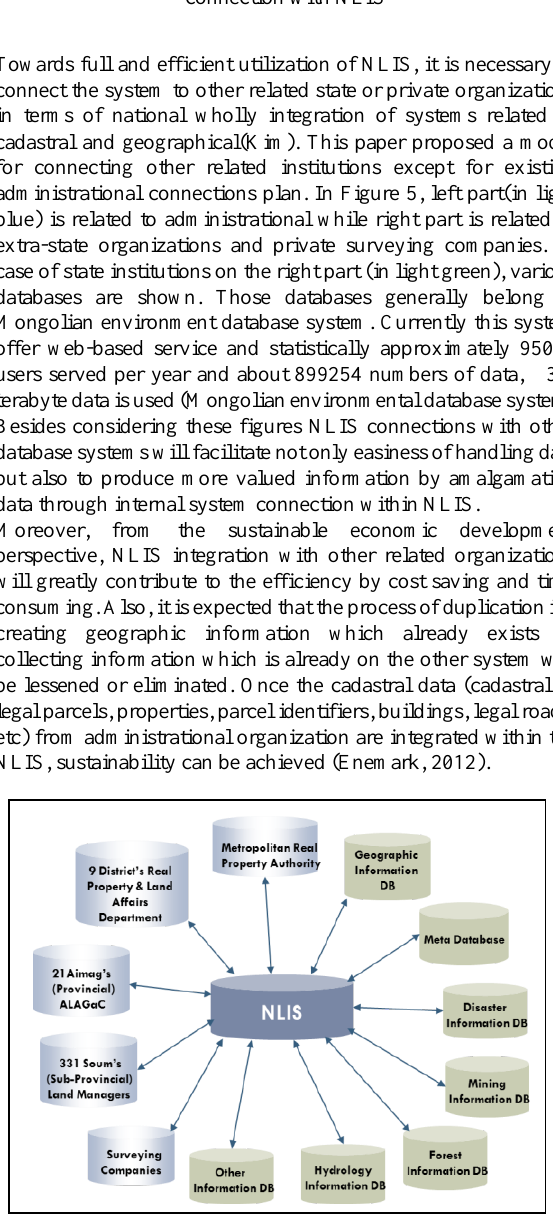
Figure 5. Proposed model of NLIS